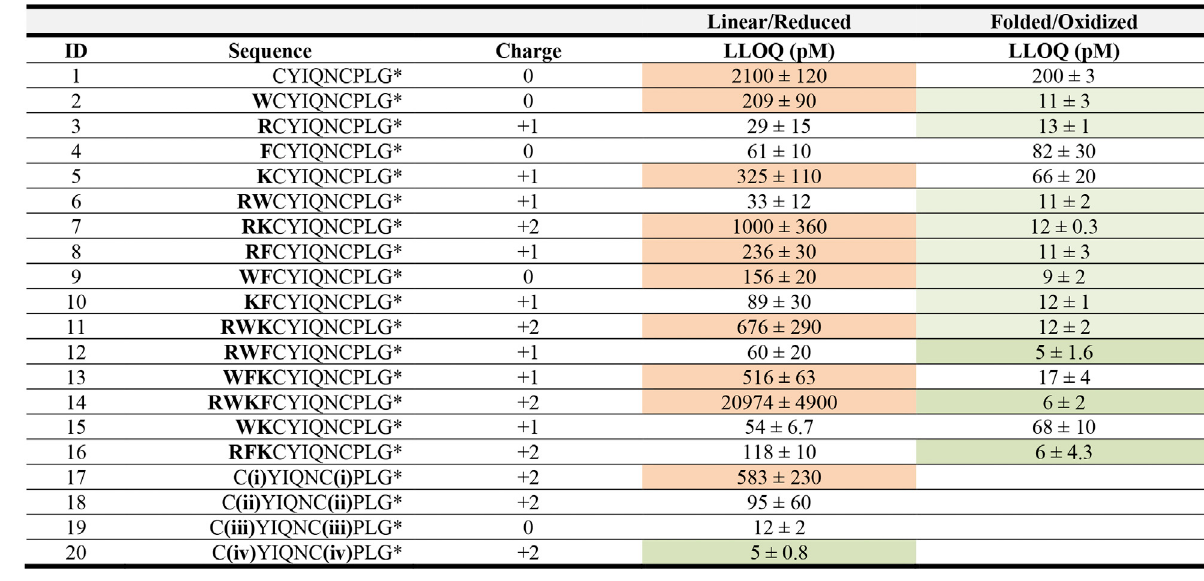
TABLE2| LLOQvaluesofOTanaloguesin50%ACN aq /0.1% FA.Adilutionseriesofeachpeptiderangingfrom1 fMto1 mMin50%ACN aq /0.1%FAwasmeasured( n =3) on the API4000 QTRAP. LLOQ was determined by visual examination of the calibration curve and ensuring the signal was ≥ 5x the blank. LLOQ values < 20 pM (more sensitive thanOT)arehighlightedingreen, > 200 pM inred,valuesbetween20and200 pMingreyand thefour sequenceswiththelowestLLOQ valuesinadarkershadeof green. (i) 4-bromo-N,N,N-triethylbutan-1-amminium, (ii) 3-(4-bromobutyl)-1-butyl-1H-imidazol-3-ium, (iii) iodoacetamide, (iv) 1-(4-bromobutyl)-4-methylpyridin-1-ium, * indicates C-terminal